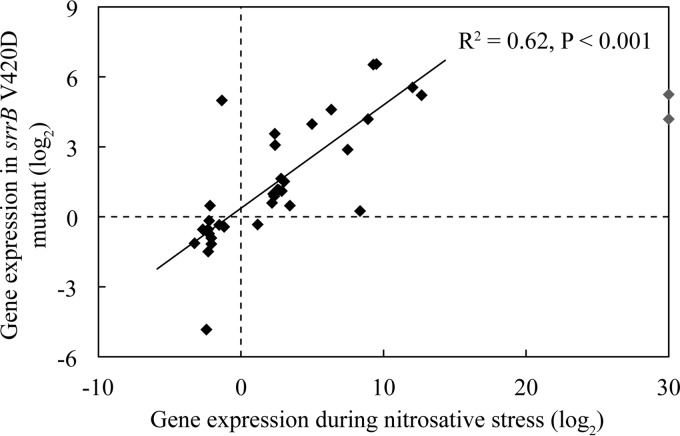
Correlation in the patterns of gene expression associated with SCV suppressor mutation affecting SrrAB and nitrosative stress. Shown is a comparison of the pattern of gene expression associated with the SCV suppressor mutation srrB V420D with that previously associated with nitrosative stress (28). Two outliers (nrdD and nrdG) are indicated in gray.